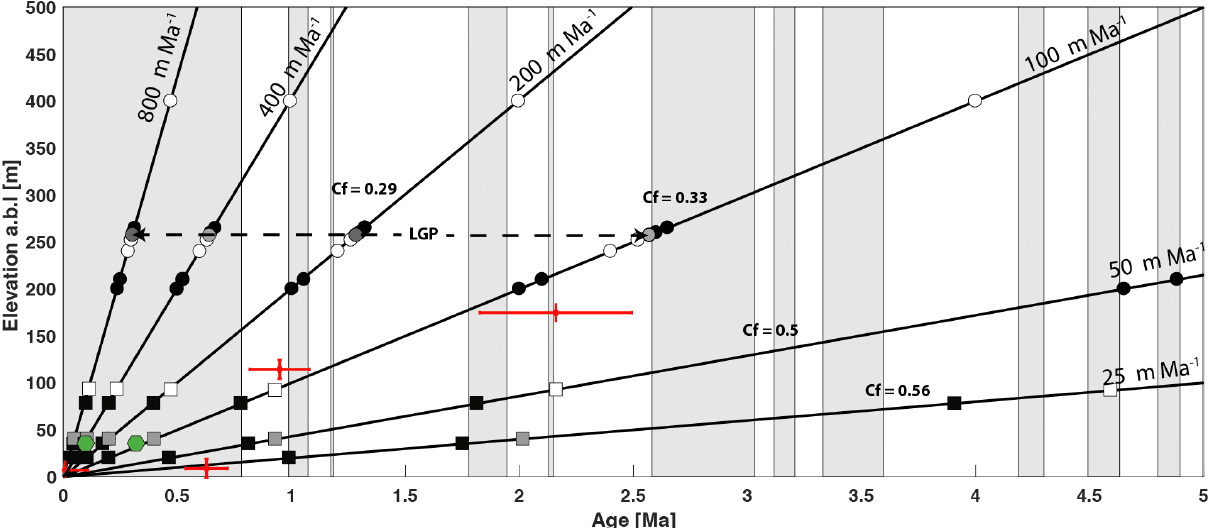
Figure 6. Constraining the incision rate in the Cévennes margin, using paleomagnetic polarities from clay deposits (black, grey, and white symbols) and burial ages (red crosses). Circles are from the Leicasse cave system, with LGP being the les Gours sur Pattes profile (see text); squares are from the Garrel cave system. Black, grey, and white symbols correspond to normal, transitional, and reverse polarities, respectively. Straight black lines define possible incision rates that are supposed stable through time (numbers in white rectangles define the correlation factor (Cf) values between the measured paleomagnetic polarities and the predicted paleomagnetic scale (see also Fig. 8). Green hexagons show the U − Th ages obtained on speleothems in the Garrel cave system by Camus